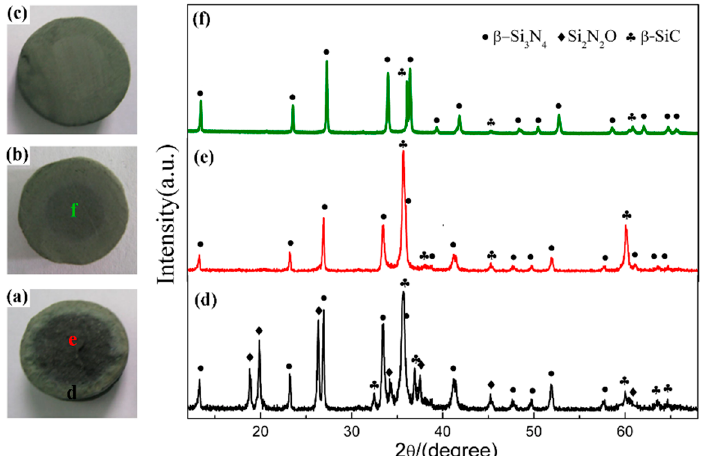
Figure 4. Digital photos of sample S1 nitrided at 1600 °C with different holding time: ( a ) 1 h, ( b ) 2 h, ( c ) 3 h; and XRD patterns of sample S1 in different regions: ( d ) exterior region and ( e ) interior region of pellet reacted for 1 h, ( f ) interior region of the pellet reacted for 2 h.